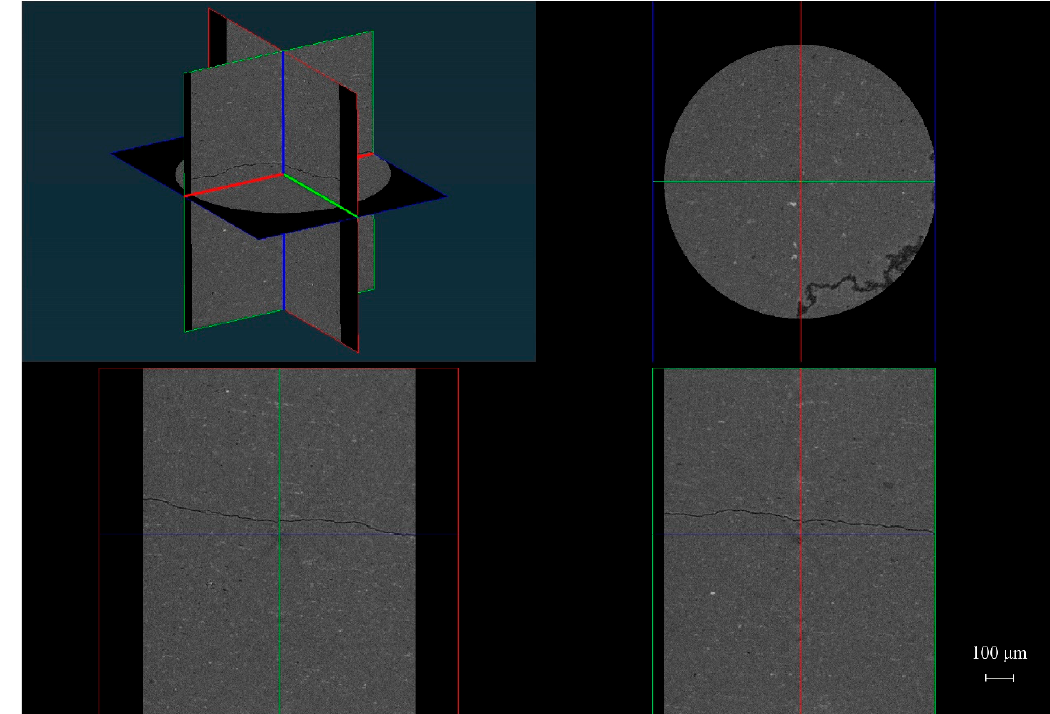
Figure 3. 3D reconstruction of the S41 shale sample.